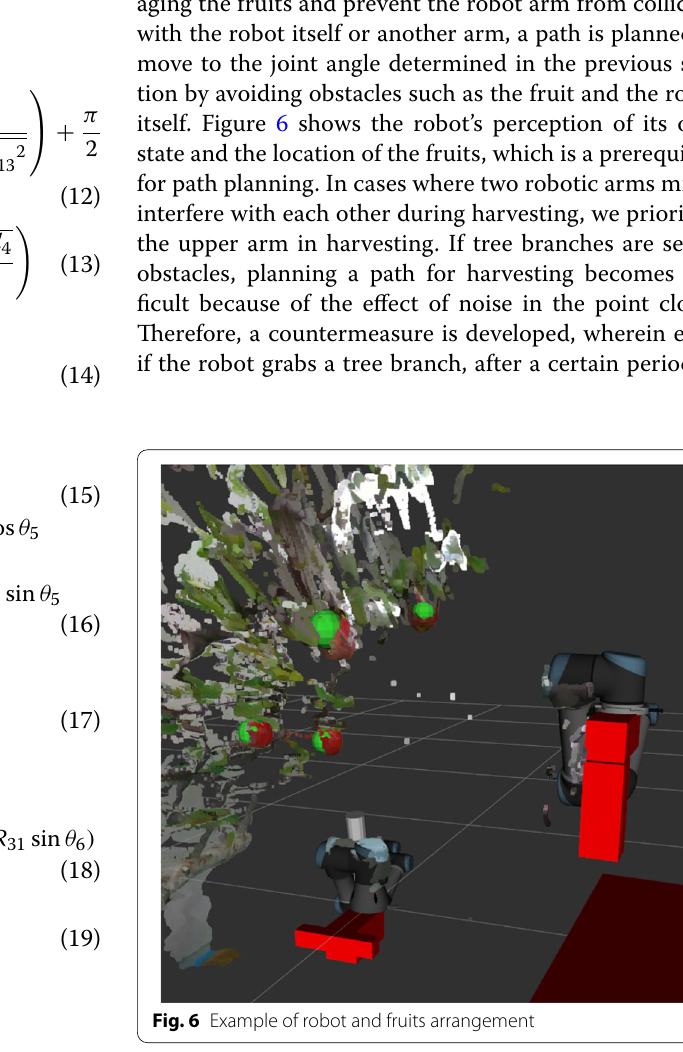
1, 2, . . . , 6 ) The angles θ i ( i = of each joint in Eq. (10) and Eq. (11) of UR arms are as follows, where a i , d i are the parameters for the Denavit-Hartenberg notation.